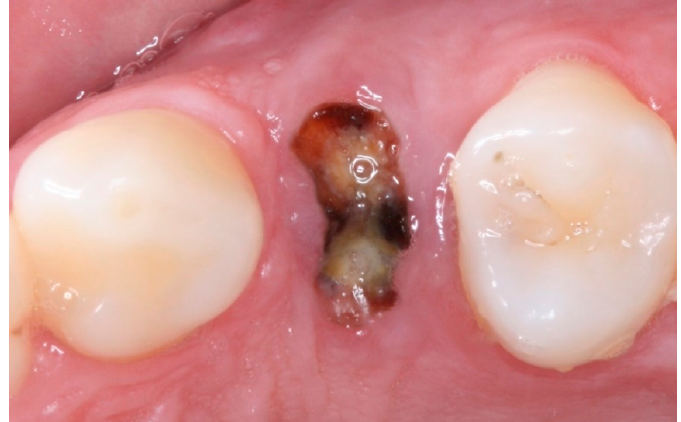
Figure 5. Intraoral occlusal view of the suture-stabilized membrane (TG1).